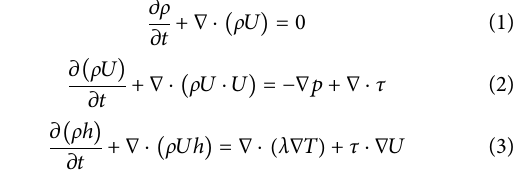
spanwise distribution of total pressure loss coef fi cient and deviation angle of different meshes is drawn in Supplementary Figure S4. When the number of grids is above 1.65 million, the